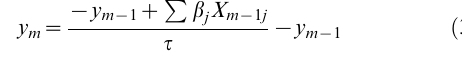
Figure S1 Significance analysis of betweenness values in the CLR-inferred macrophage network. Z scores (Y axes) were calculated for the real betweenness values versus the mean betweenness of the node with the same betweenness rank (X axes) in 100 networks with 50% or 0.1% of the edges rewired. The results show that the betweenness values in real inferred networks are very different from those in randomized networks, even when the networks have been perturbed very little. Table S1 List of genes considered in network inference and response set analysis. Response group analysis, a 1 indicates that the gene was found to be differentially regulated (fold change 1.5) in the specified